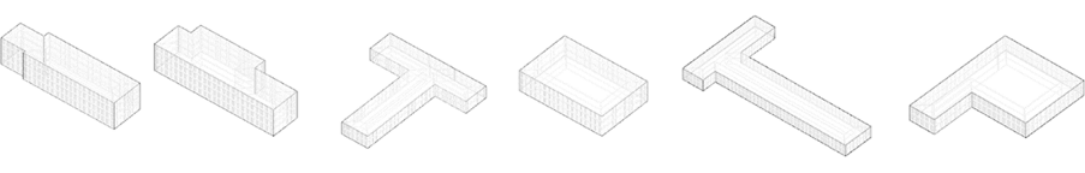
Figure 7. Examples of building shapes generated by script, used to train the Machine Learning model.